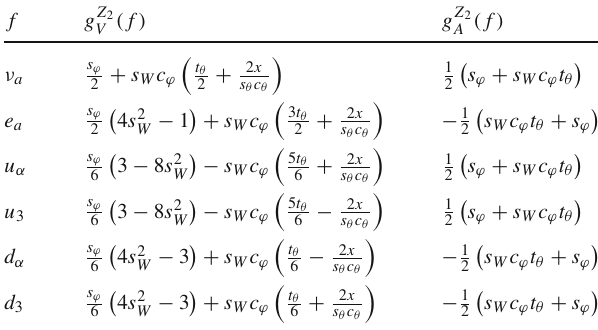
Table 3 Couplings of Z 2 with